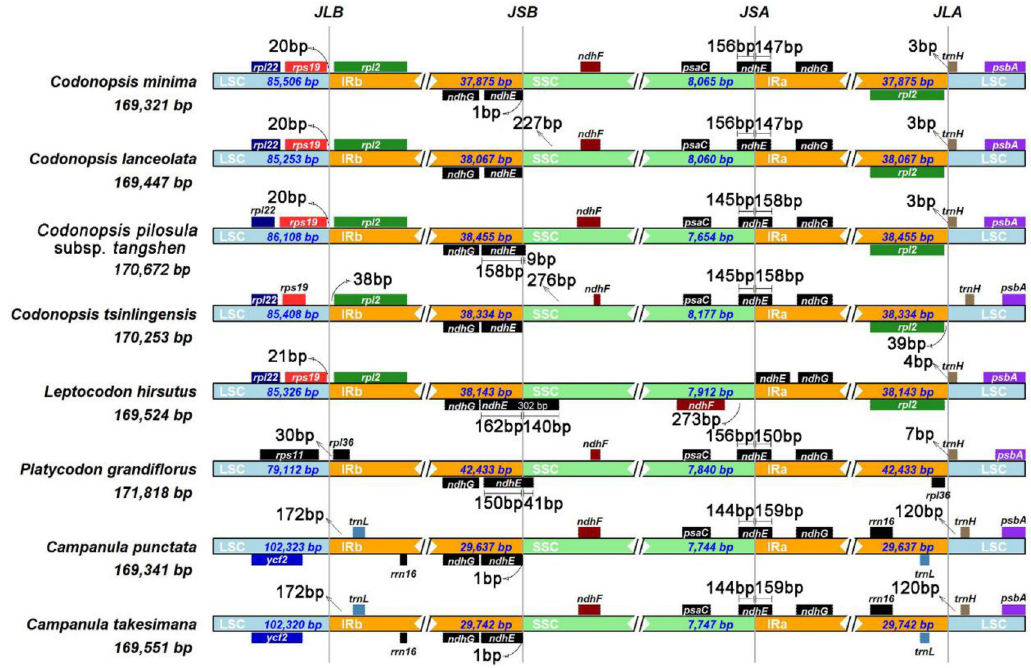
Fig 2. Comparison of LSC, IR, and SSC border among the complete plastomes of 4 Codonopsis species, 2 Campanula species, Leptocodon hirsutus , and Platycodon grandiflorus . The JLB, JSB, JSA, and JLA represent junction sites of LSC/IRb, IRb/SSC, SSC/IRa, IRa/LSC, respectively. Different colors represent different regions. The blue represents LSC, the orange represents IRs, and the green represents SSC. The number on the arrow indicates the distance between the gene and the boundary. The genes shown in Fig are the genes closest to the boundary.